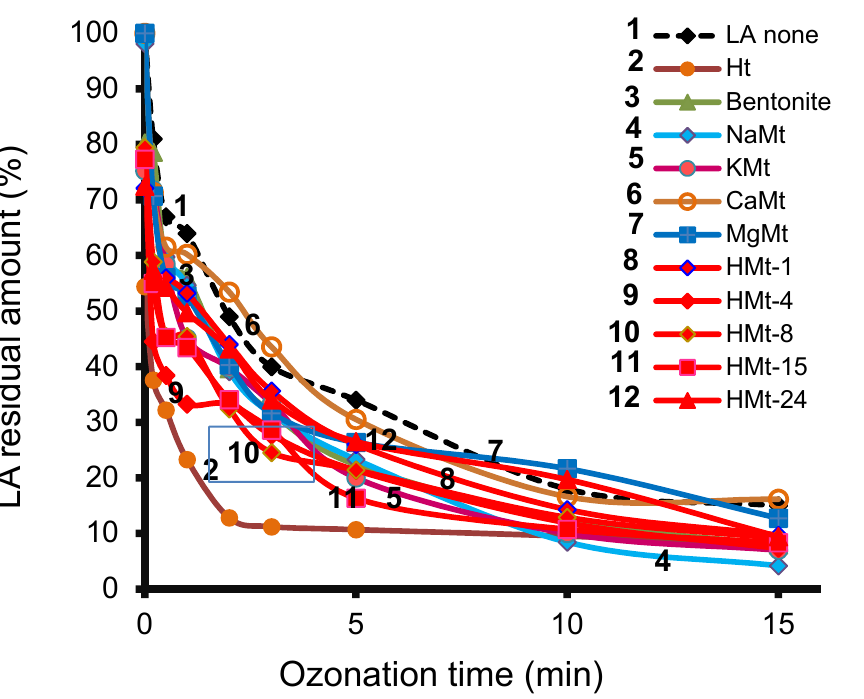
Figure 4. Effect of the addition of catalyst on LA residual amount during ozonation as assessed with HPLC-UV. Before ozonation, all cationic clay suspensions were stirred manually for 3 min for homogenization. Ht suspension was previously prone to a vigorous magnetic stirring for 120 min.